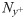
Data transmitted and received at Node Ny.Note: Ny+ and Ny− represent the next hop and the last hop of Node Ny, respectively.